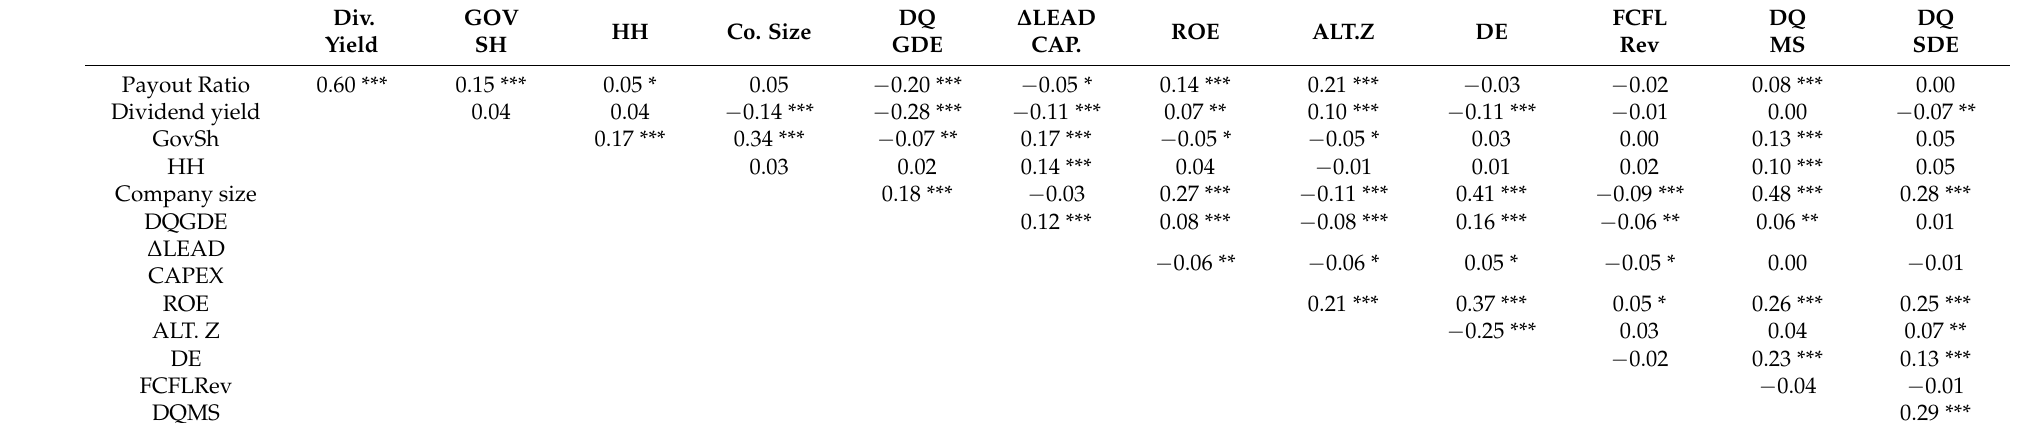
Table 3. Pearson correlations between pairs of continuous